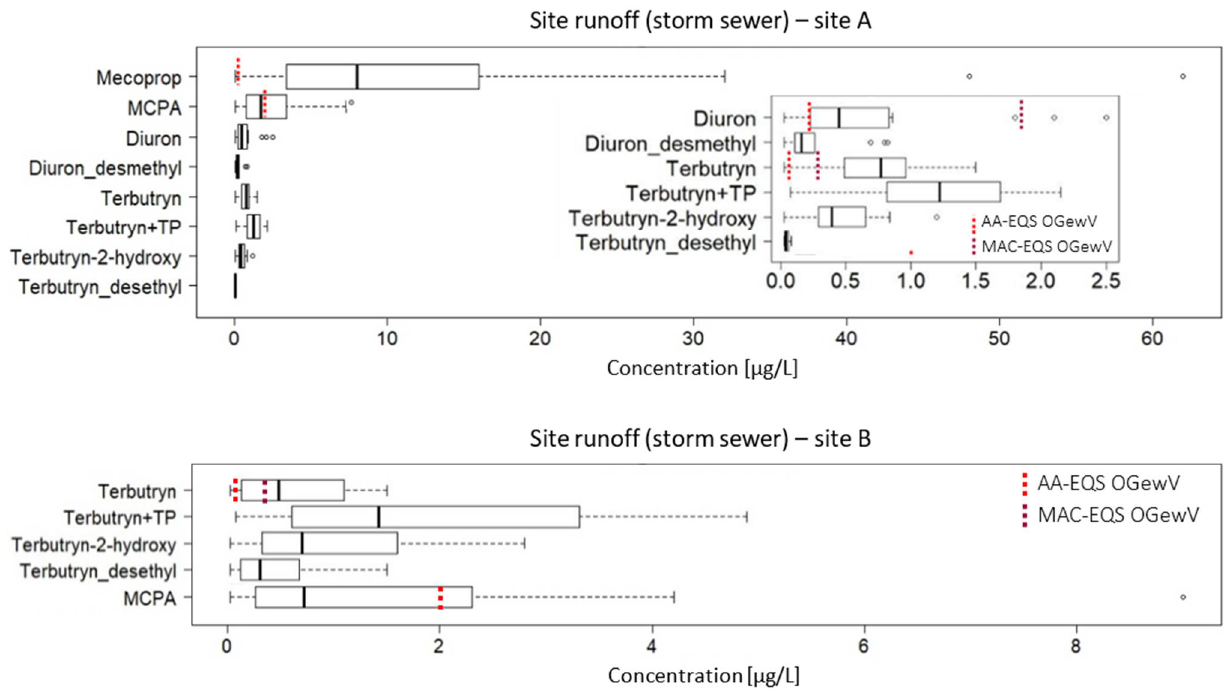
Figure 4. Concentration of micropollutants in site runoff (storm sewer) of site A and B.